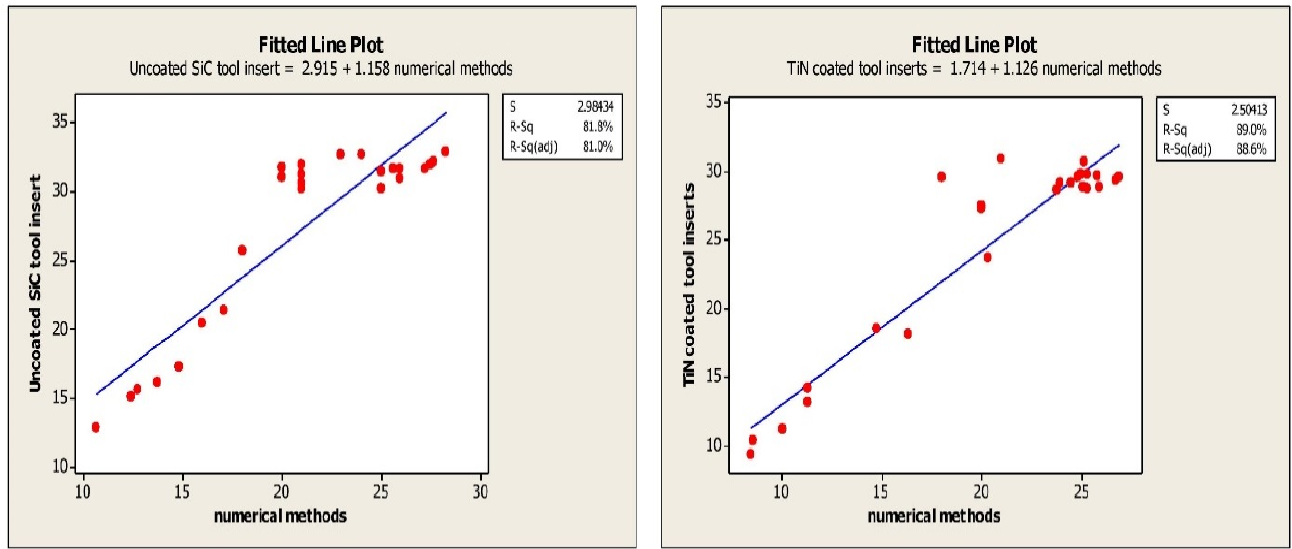
Figure 5. Linear Curve fitting of experimental vibration frequencies and FEM vibration results.